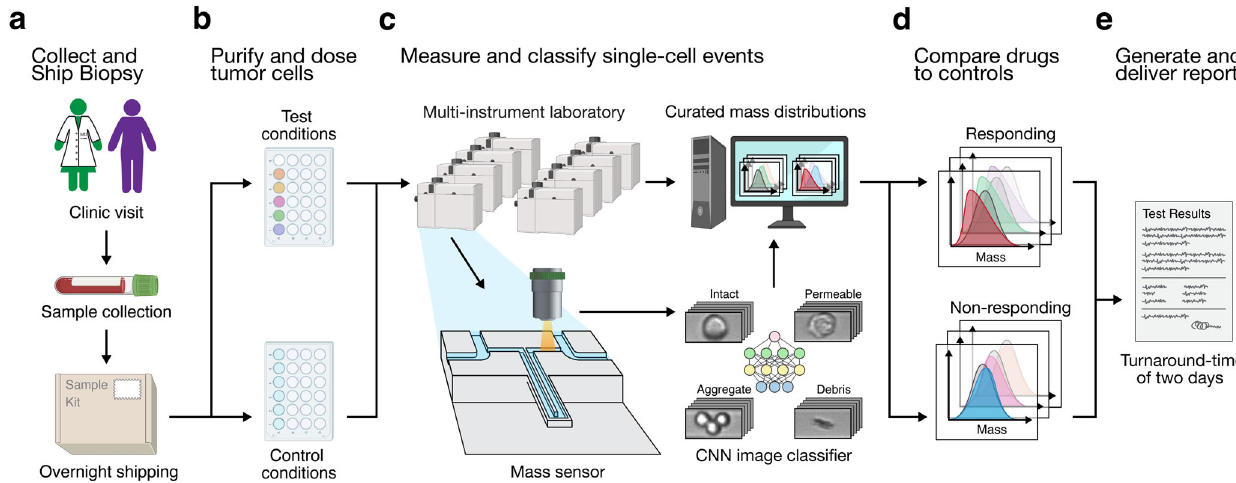
Fig. 1 Clinical pipeline for cancer drug responsiveness testing using image-curated single-cell mass measurements. Schematic overview of the full drug testing pipeline including a sample collection and shipment, b tumor cell isolation and overnight drug incubation, c single-cell mass data collection using more than twelve SMR-based instruments with linked bright fi eld imaging, downstream image classi fi cation, d statistical analysis, e response calling and results